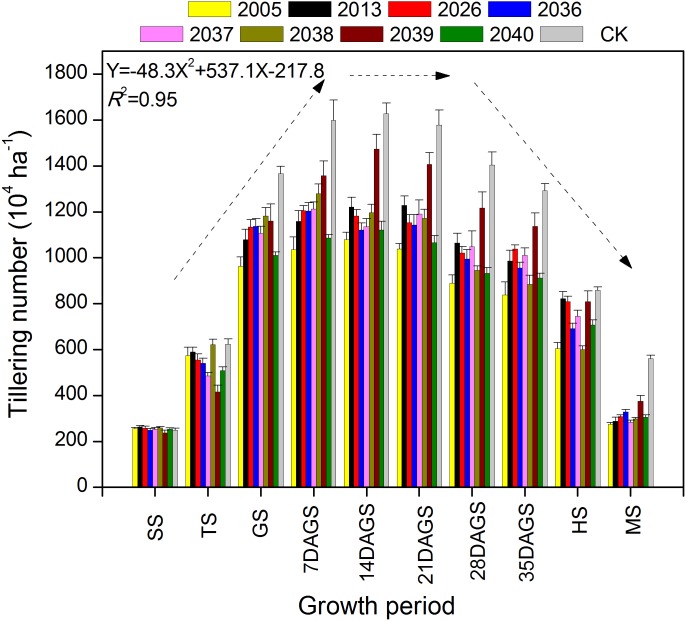
The dynamic changes in tiller number in eight large-spike wheat lines and one multiple- spike cultivar (Xi’nong 979) from seeding to mature stage.SS, seeding stage; TS, tillering stage before winter; GS, returning green stage; 7DAGS, 14DAGS. 21DAGS, 28DAGS, and 35DAGS indicate 7, 14, 21, 28, and 35 d after returning green stage, respectively; HS, heading stage; MS, mature stage.